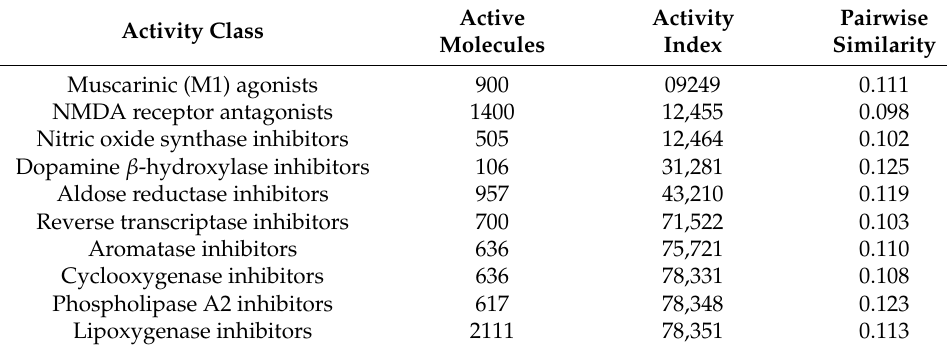
Table 3. The MDDR-DS3 structure activity